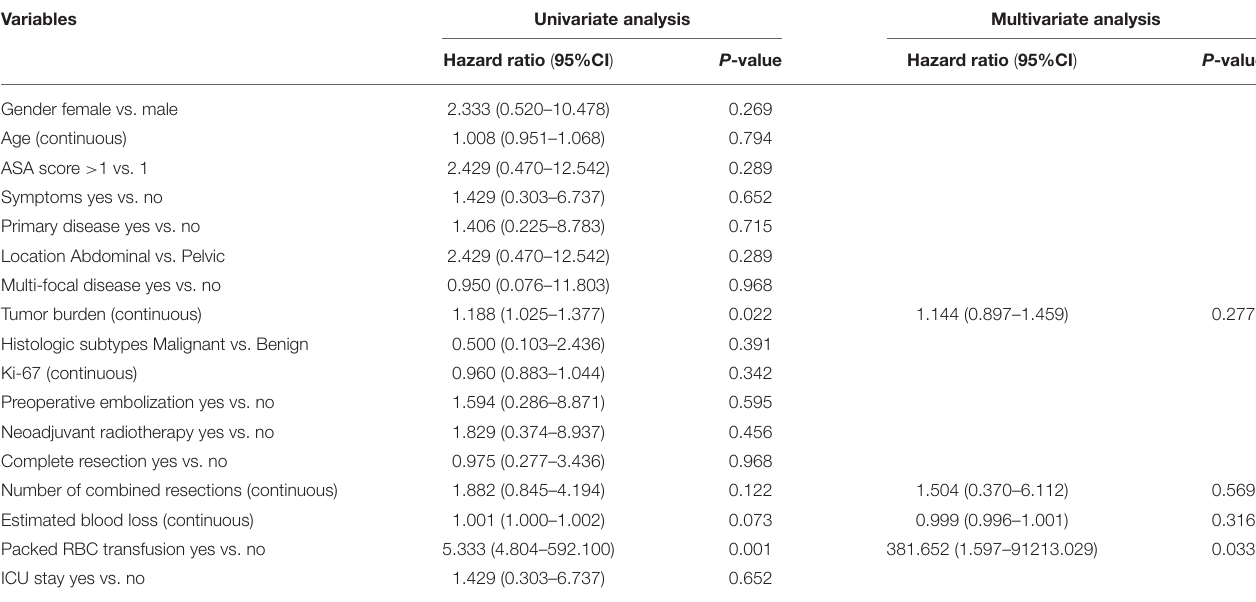
TABLE 2 | Univariable and multivariable analyses to determine independent predictors of adverse events of retroperitoneal solitary fibrous